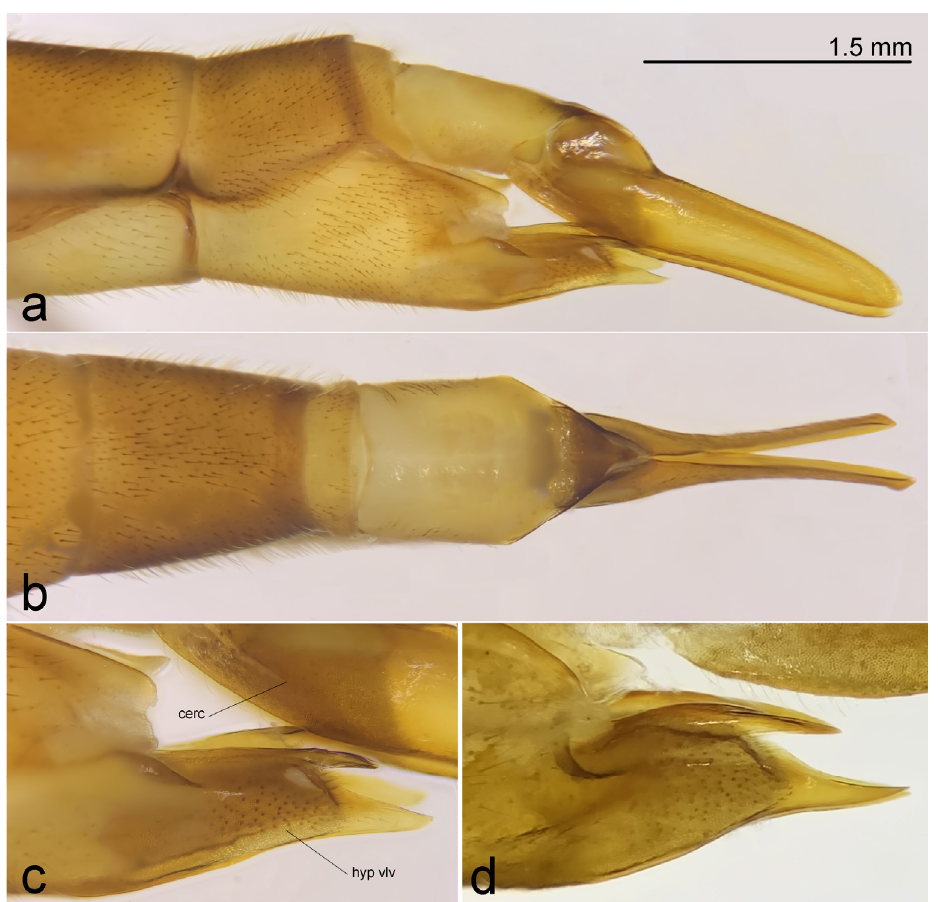
Figure 10. Zelandotipula gelhausi sp. nov., paratype female; ( a ) Ovipositor, lateral view; ( b ) idem , dorsal view; ( c ) Detail of hypogynial valve, lateral view; ( d ) Zelandotipula parviceps , holotype female, detail of hypogynial valve in lateral view.